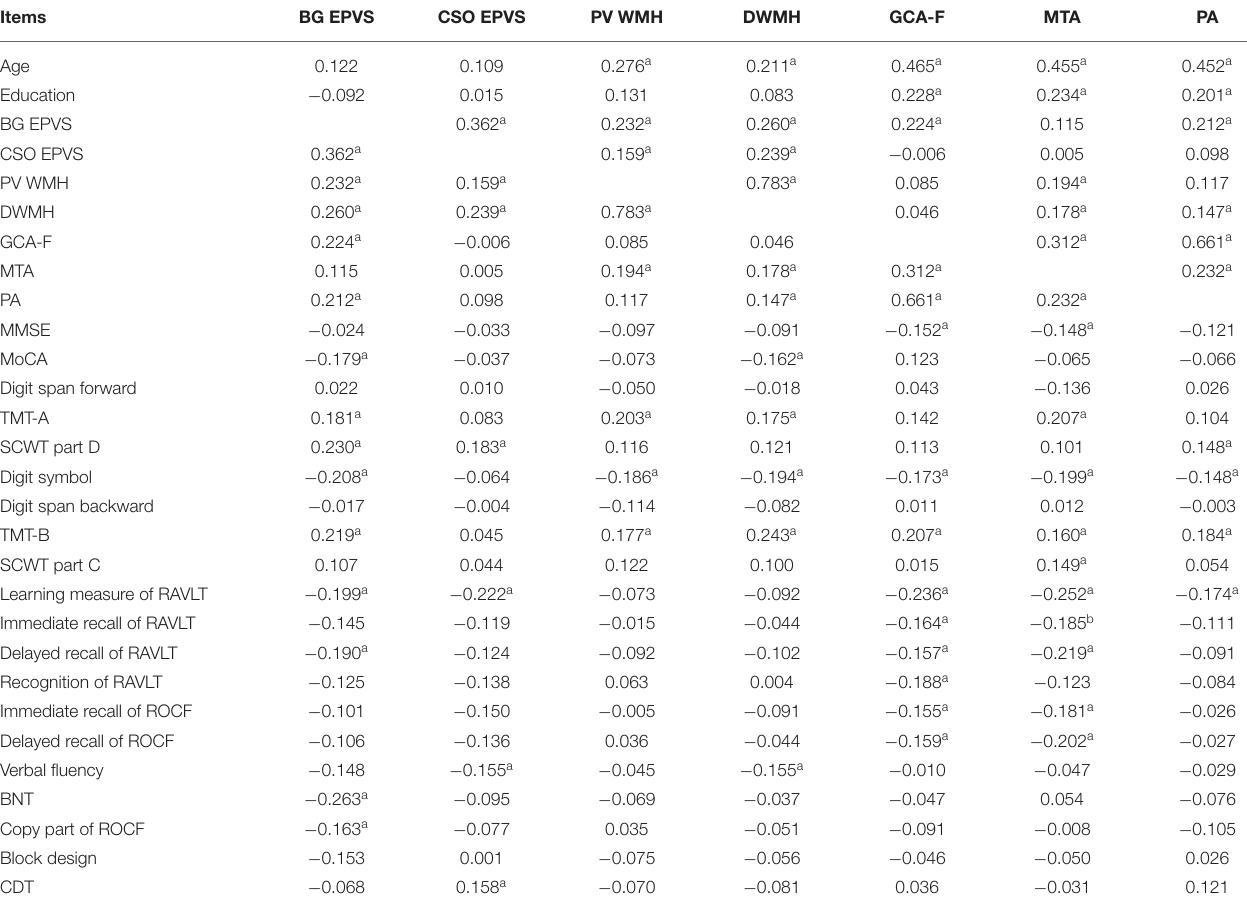
TABLE 3 | Correlation between imaging variables and age, education, and scores of cognitive tests in MCI groups.